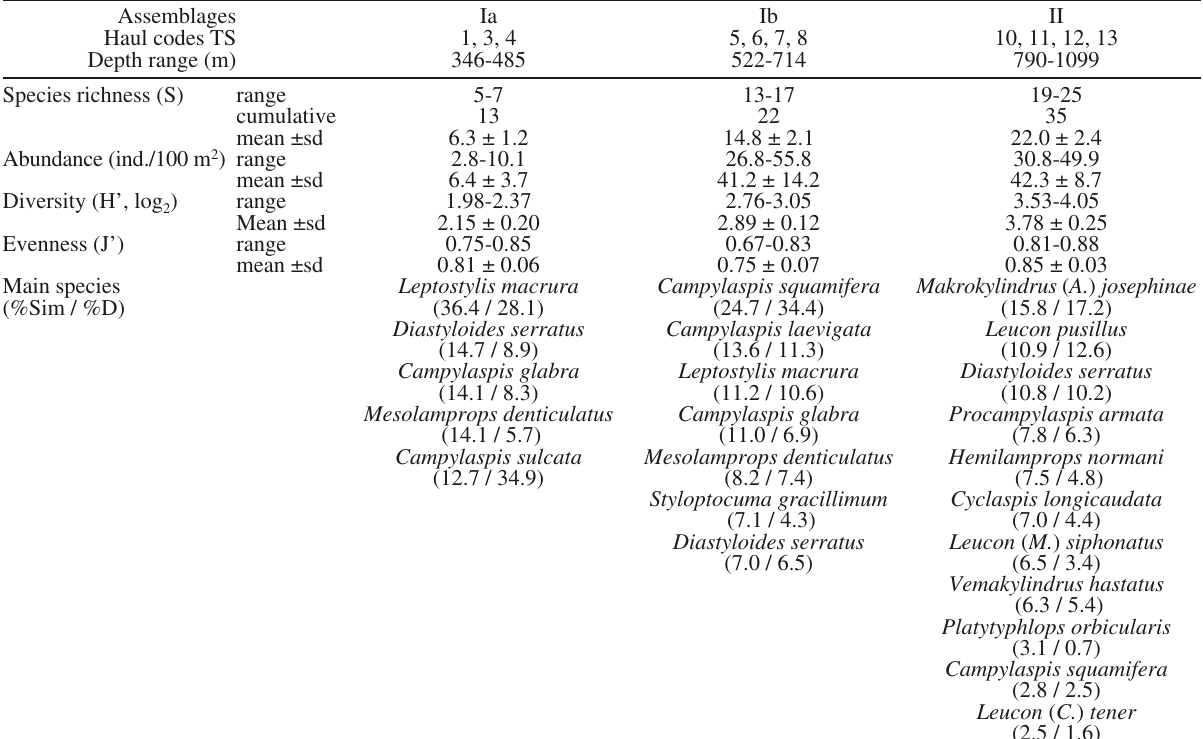
Table 6. – Biotic characteristics of the cumacean assemblages Ia, Ib and II discriminated by the multivariate analysis of abundance data (based on cumulative values from nets N1-N4). Species ranked according to their average contribution to within-group similarity (%Sim); their respective contribution (%D) to mean total abundance of each assemblage is also included. A cut-off at a cumulative similarity of 80% was applied; sd, standard